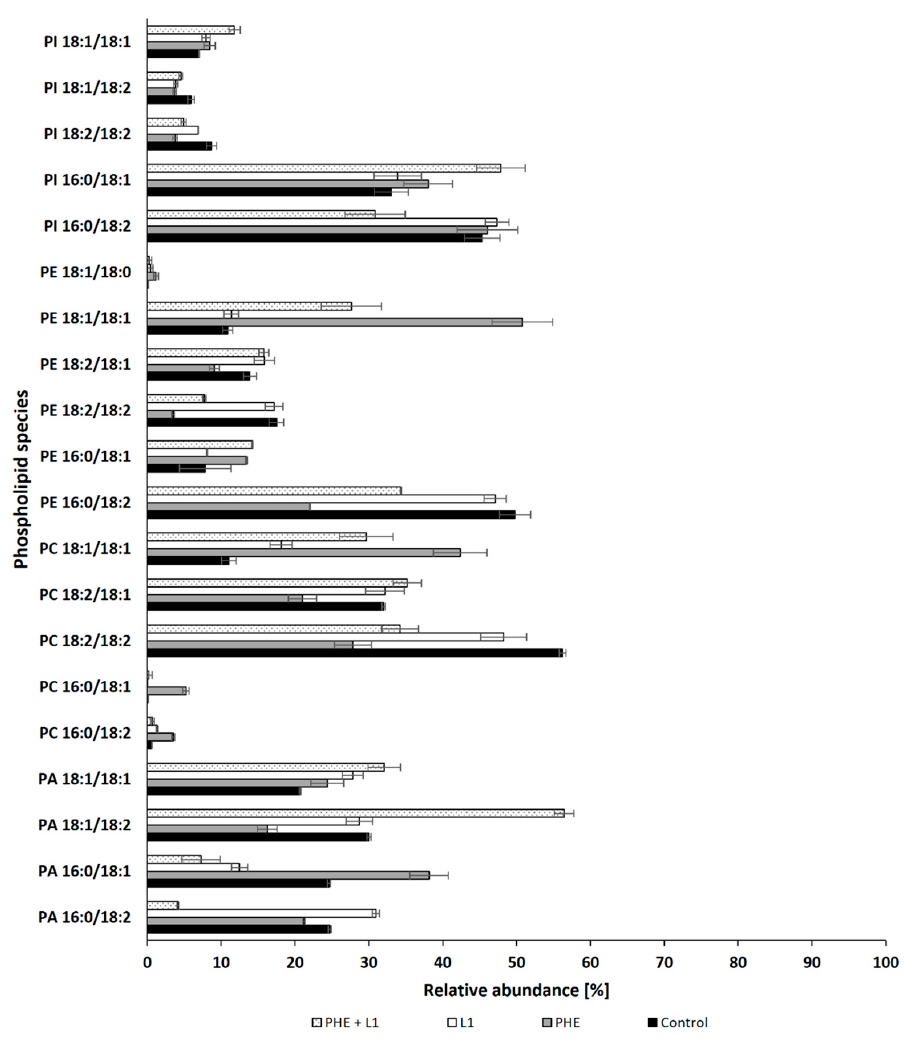
Figure 5. Relative abundances (%) for the main species of phospholipids in cultures of N. pironii supplemented with PHE, L1, or PHE + L1.